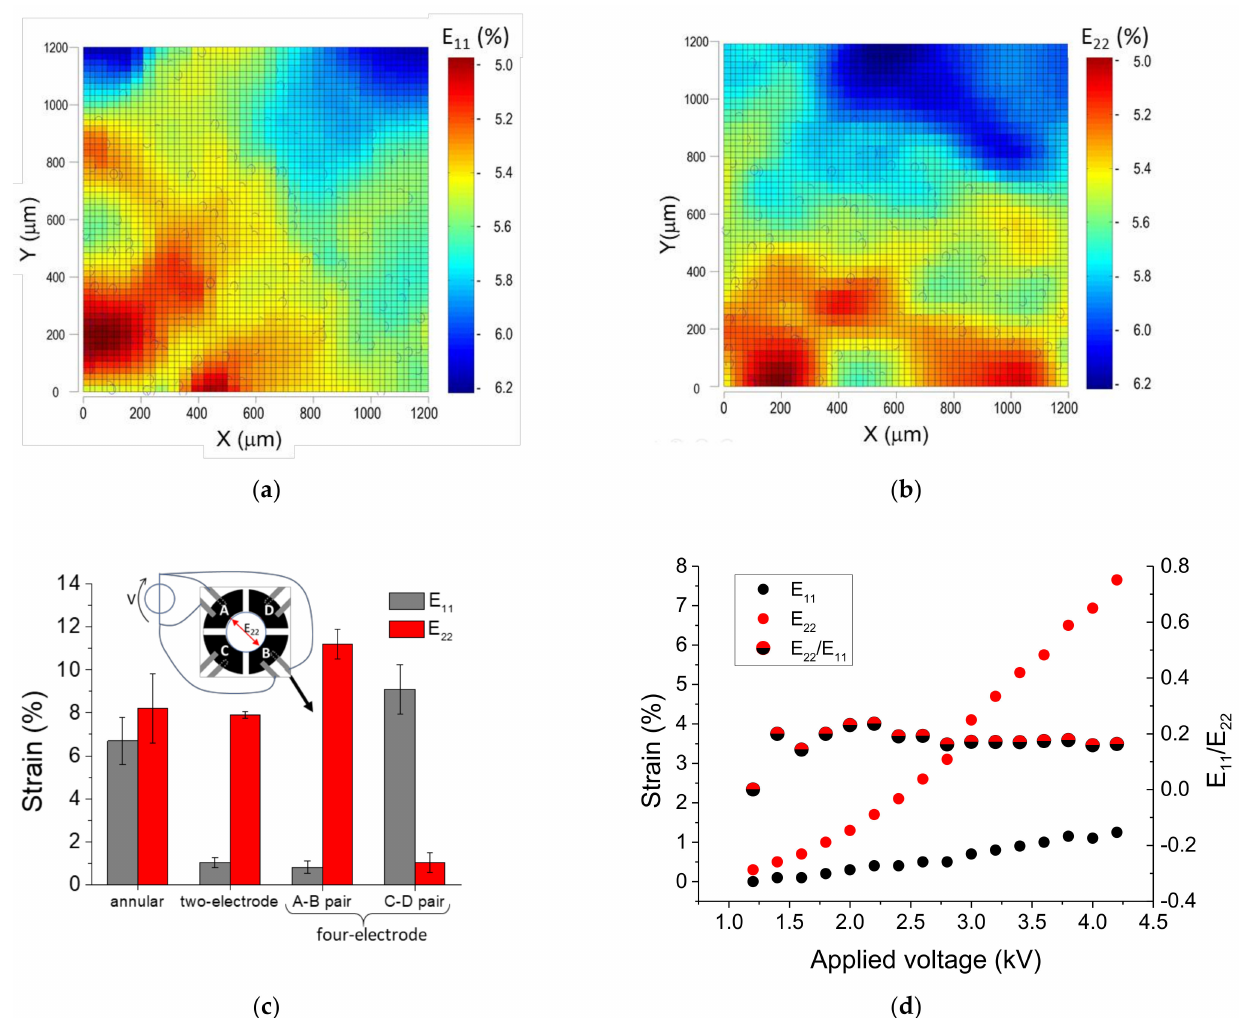
Figure 7. Static characterization of the deformation. ( a , b ) typical strain fields for a device with annular configuration, the blue circles represent the initial position of the tracking beads; ( c ) maximum strains (average and standard deviation) obtained with devices in the annular, two- and four-electrode configurations when the voltage V is applied either to the A–B pairs or to the C–D pairs; ( d ) strain performance of a device in the two-electrode